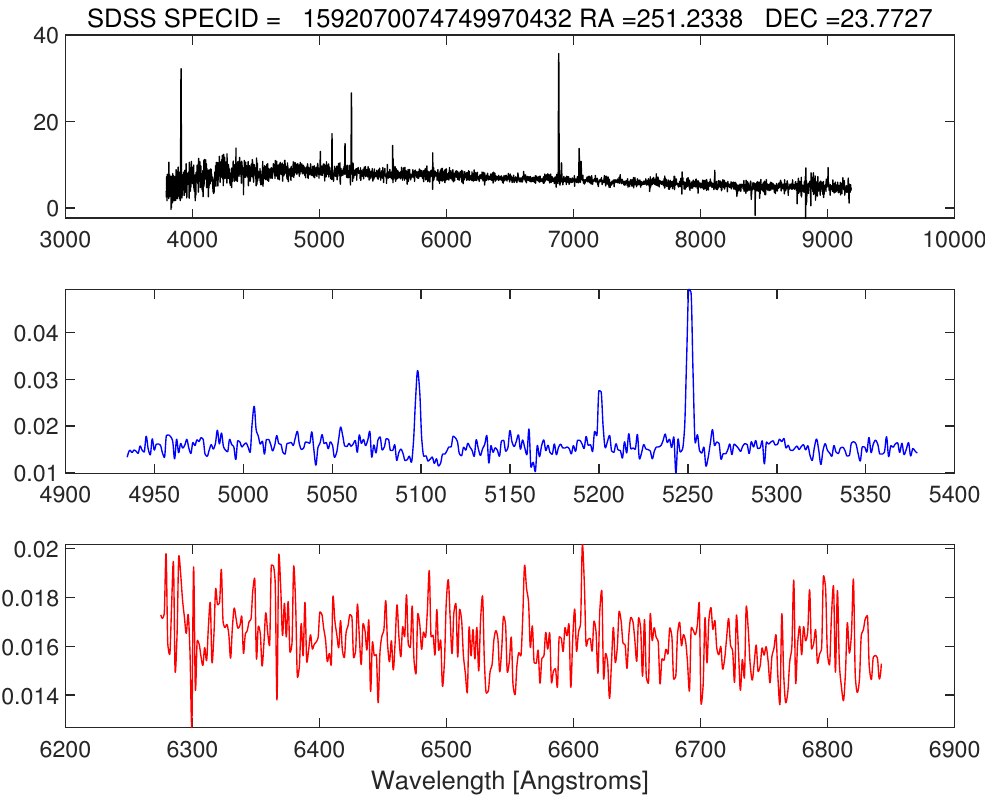
Figure 1. SDSS spectrum. The top panel is the original SDSS spectrum, the middle and bottom panel are blue and red band of the